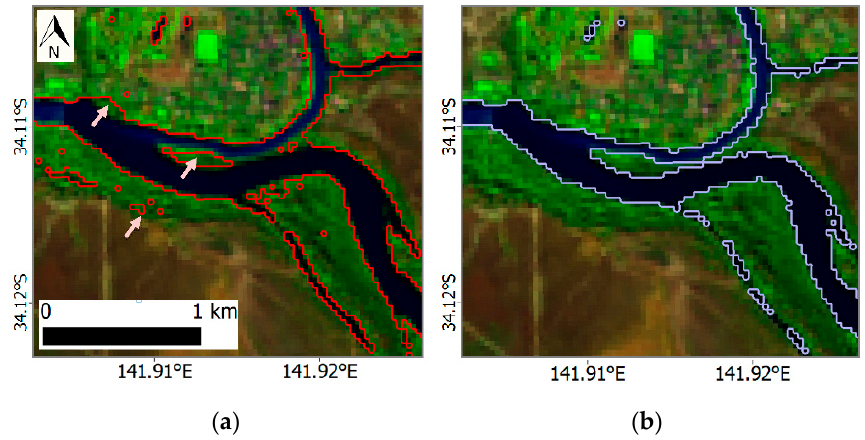
Figure 8. Water boundary classified using threshold = 0.0 ( a ) and threshold = 0.32 automatically detected for this location using the new method ( b ).